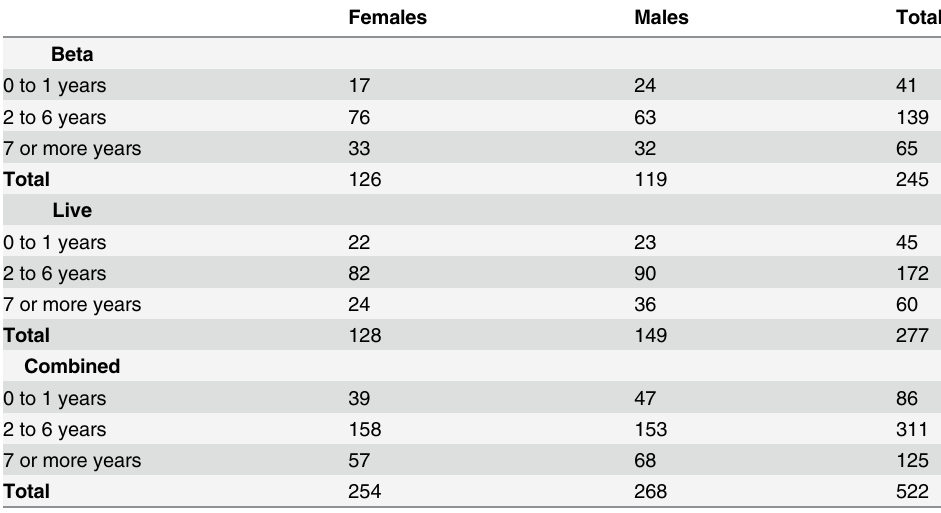
Table 1. Age and sex of subjects in Beta, Live and combined